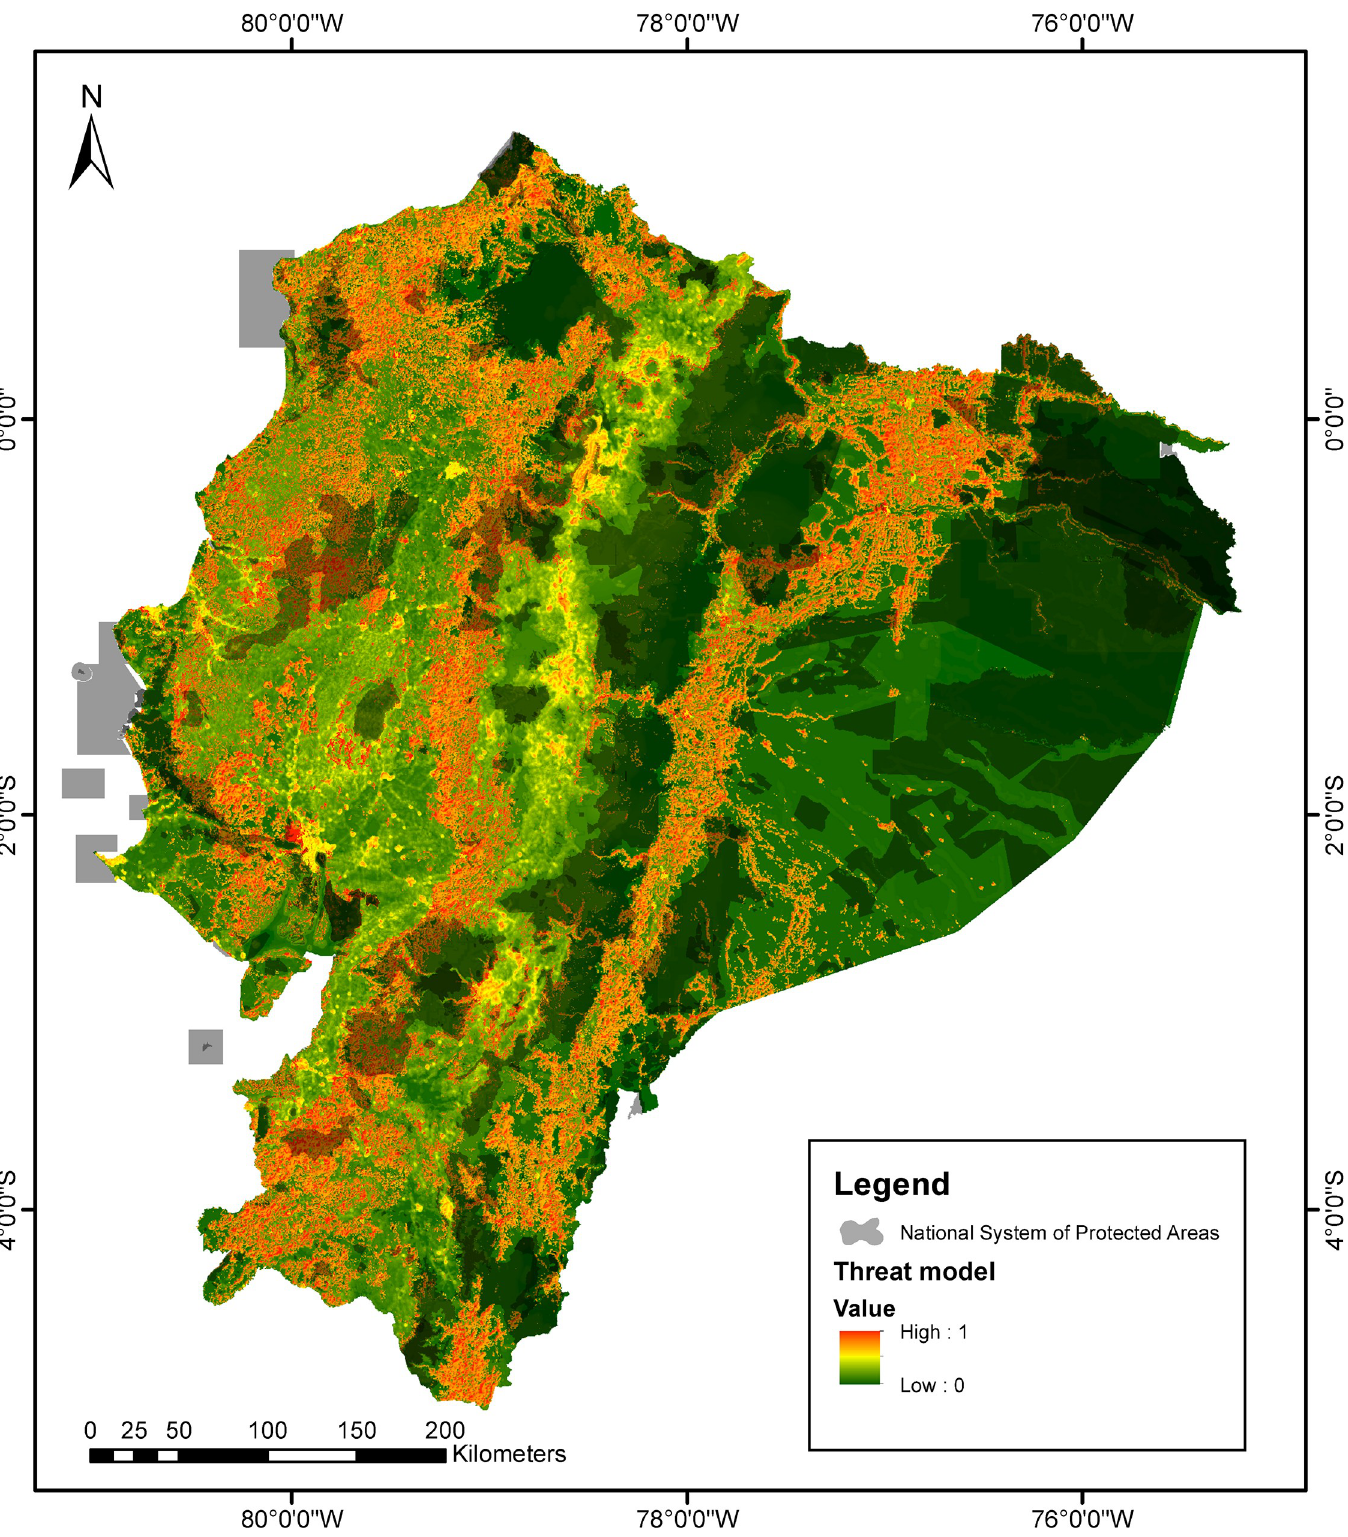
Fig 4. High resolution (30 m x 30 m) Environmental Risk Surface (ERS) model for Ecuadorian amphibians. Values of the ERS range from 0 (Green, low) to 1 (Red, high) to represent threat intensity. Shaded areas correspond to the National System of Protected areas shown in Fig 1.